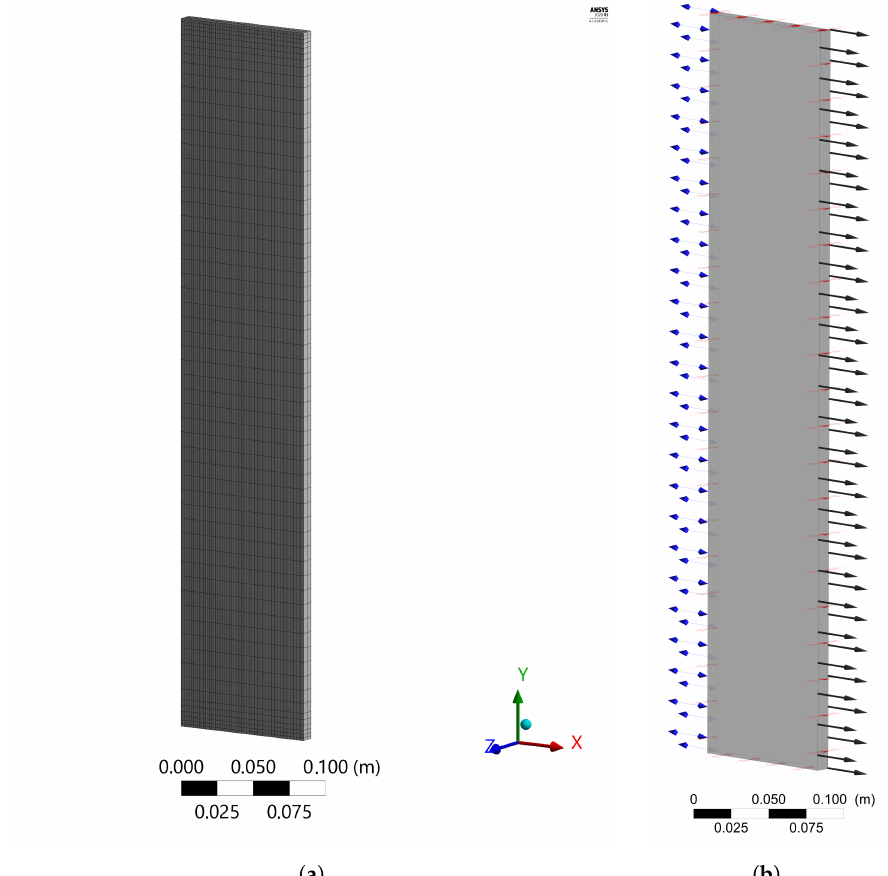
Figure 3. Meshing ( a ) and boundaries setup ( b ) of the pad model in the ANSYS CFX ® software. The inlet and outlet of the pad are represented with double and single arrows,